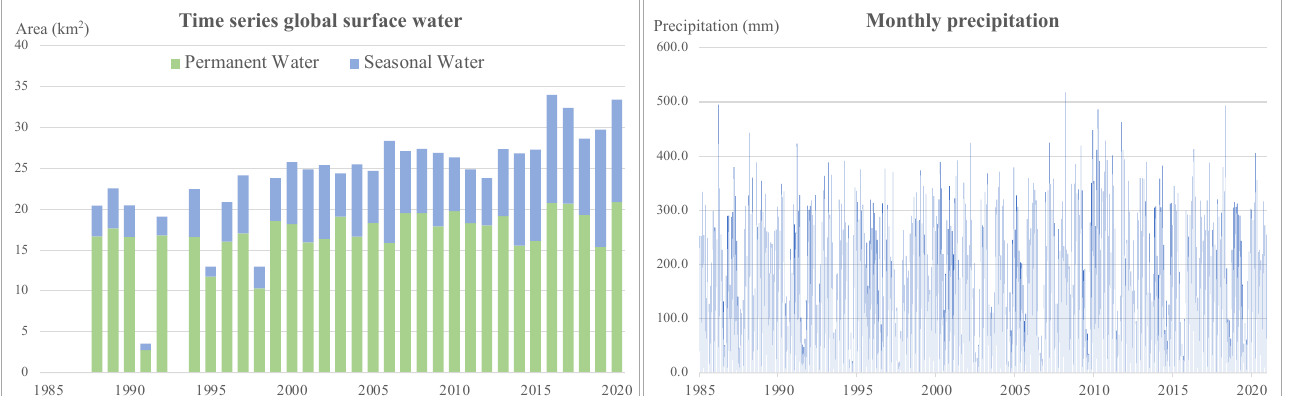
Figure 3. Transformation of active R-C-ASGM sites detected from IJ_Isoda algorithm and VH polarization.